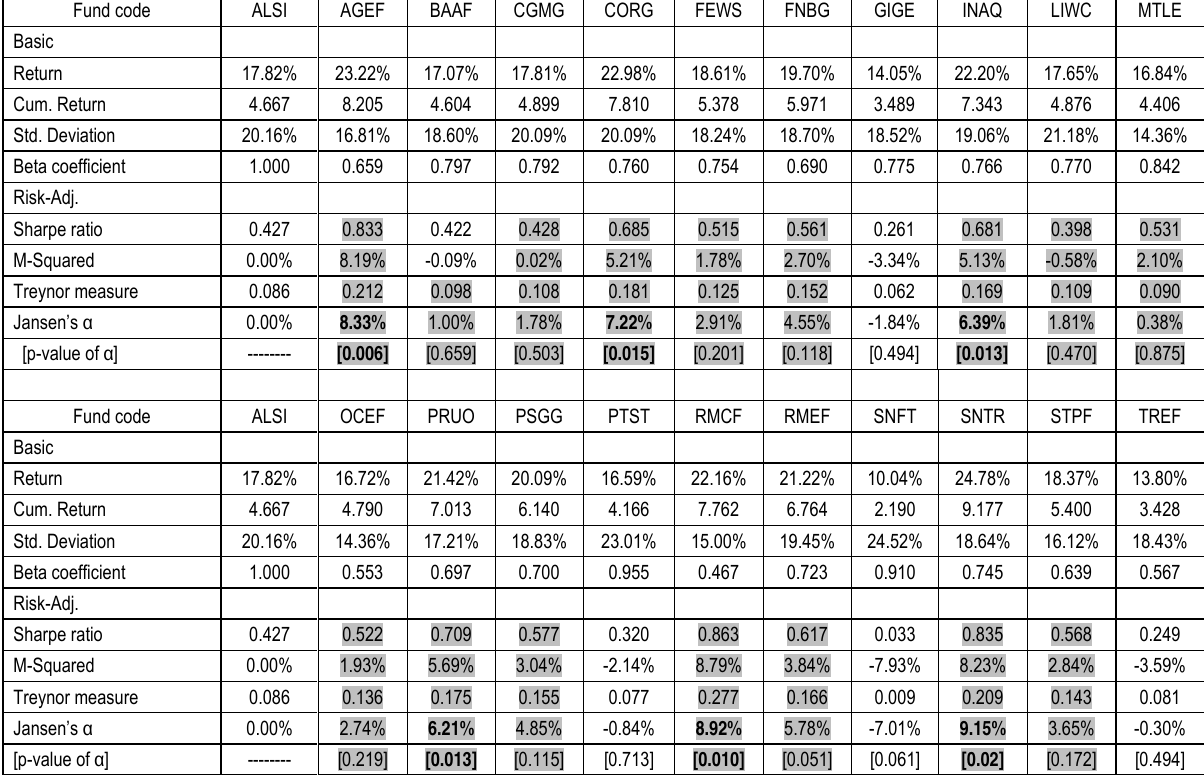
Table 3. Fund performance (Overall period: 6 Jan 2002 to 2 Sep